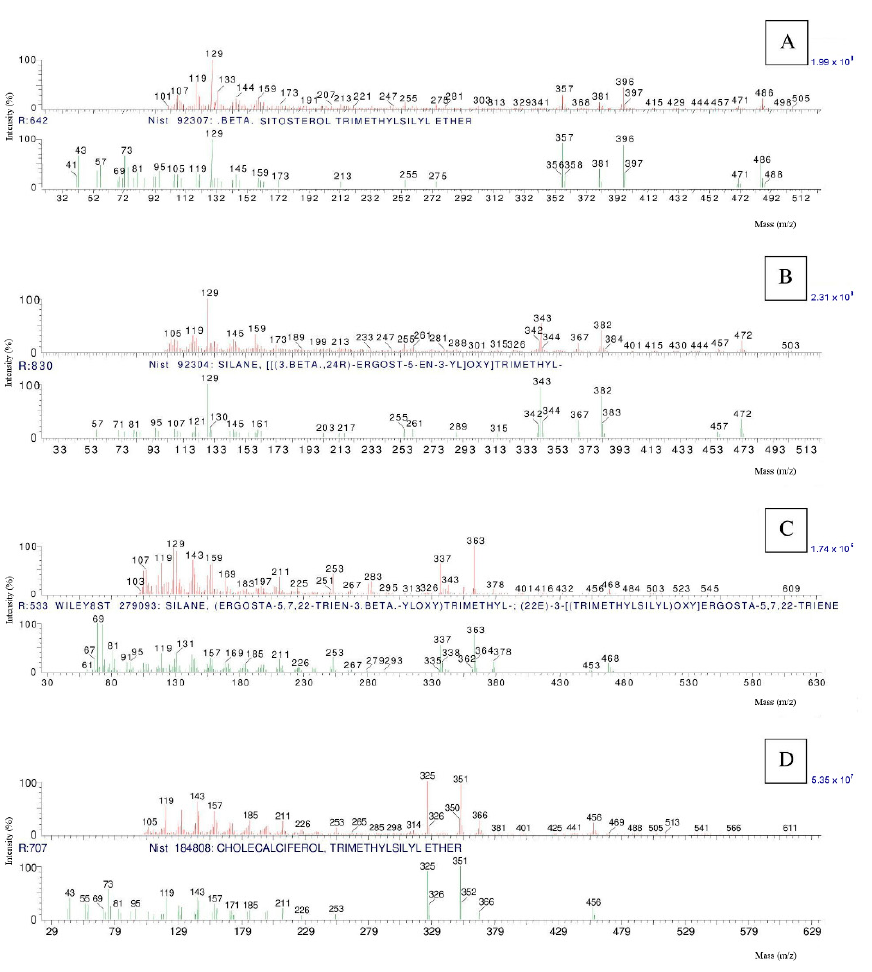
Figure 2. Chromatograms developed for the identification of sterol substances isolated from the adult bodies of P. chalcographus and I. typographus (method with KOH derivation) and the spectra of compounds ((A) β sitosterol, (B) (3. β .,24R) ergost-5-en-3-yl, (C) ergosta-5.7.22-trien-3 β -yloxy and (D) cholecalciferol). Red color = female, and green color = male.